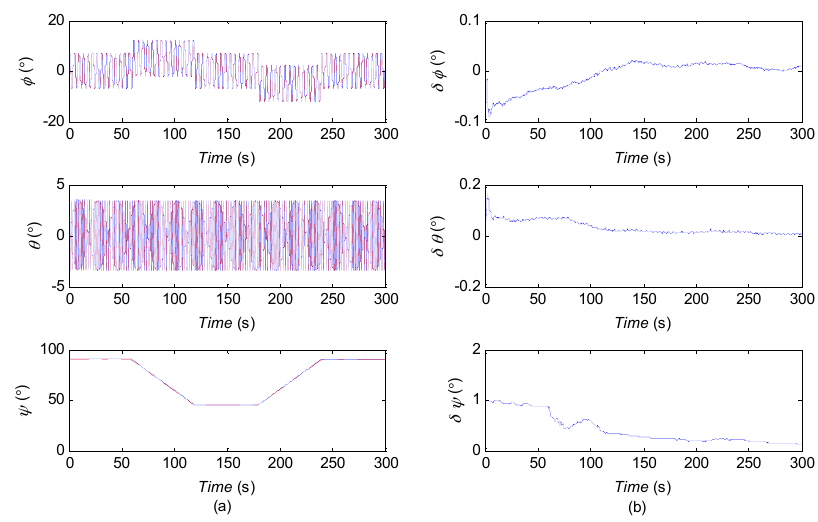
Figure 5. ( a ) roll, pitch and yaw of the USV; ( b ) estimation of the attitude errors (transformed from quaternion to corresponding Euler angles).